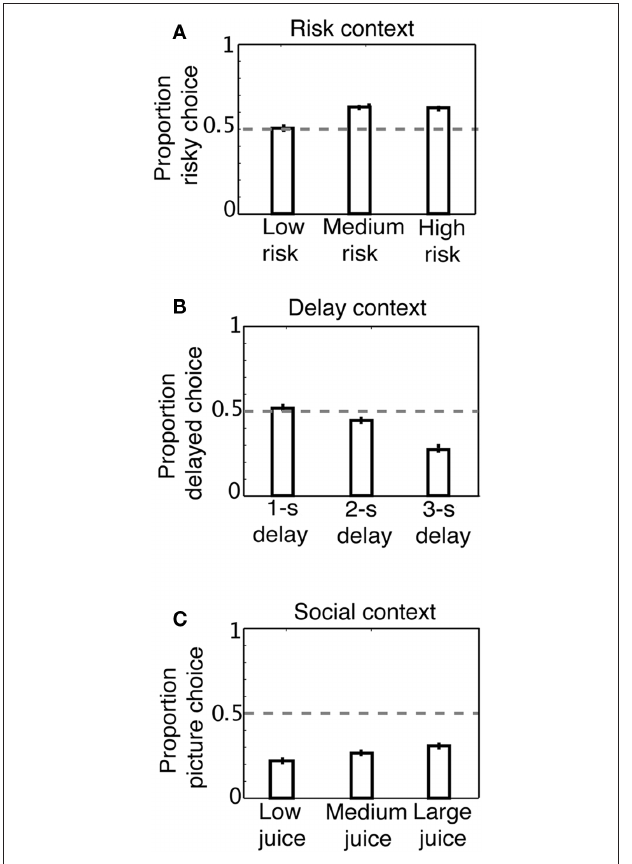
Figure 2 | Behavioral preferences used to compute subjective value in the risky, delay, and social contexts. (A) Preferences in risk context. Monkeys significantly preferred a risky reward to a safe reward and had stronger preferences for higher levels of risk. (B) Preferences in delay context. Monkeys were significantly delay-averse, preferring smaller, immediate rewards to larger, delayed rewards, and had stronger preferences against longer delays. (C) Preferences in social valuation context. Monkeys preferred the standard juice reward to smaller rewards coupled with images, but were more likely to choose to view the image as juice volume was increased.